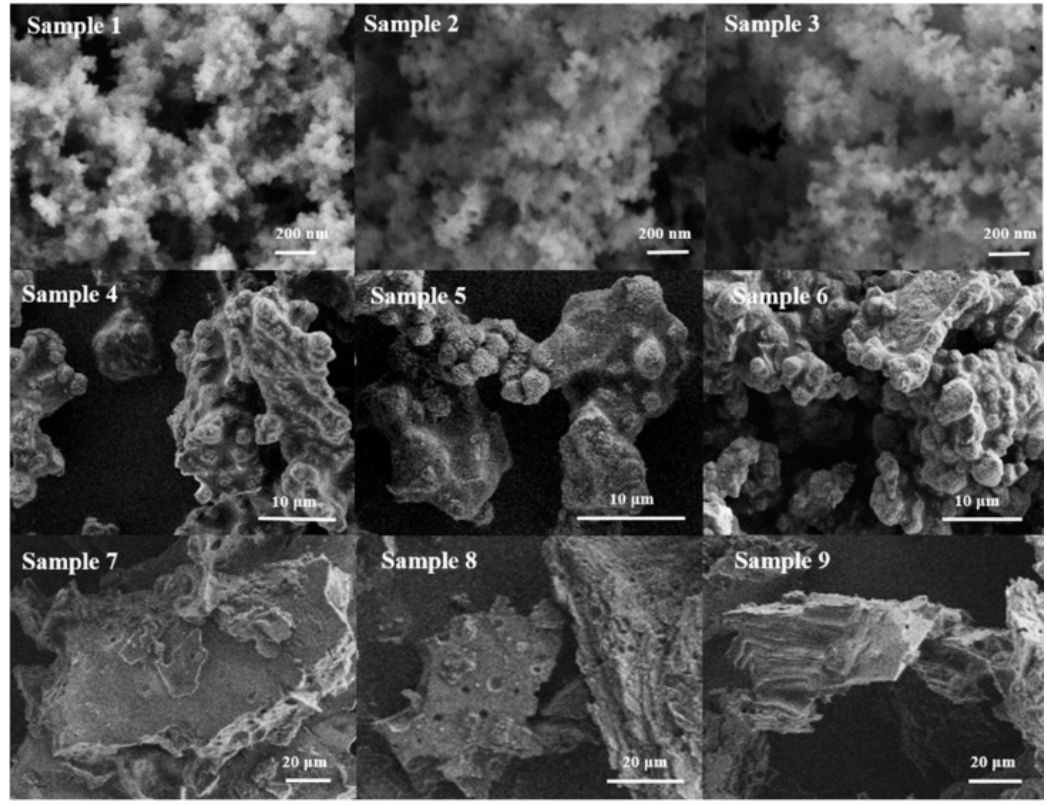
Figure 5. SEM images of Sample 1–9 with different reaction conditions.